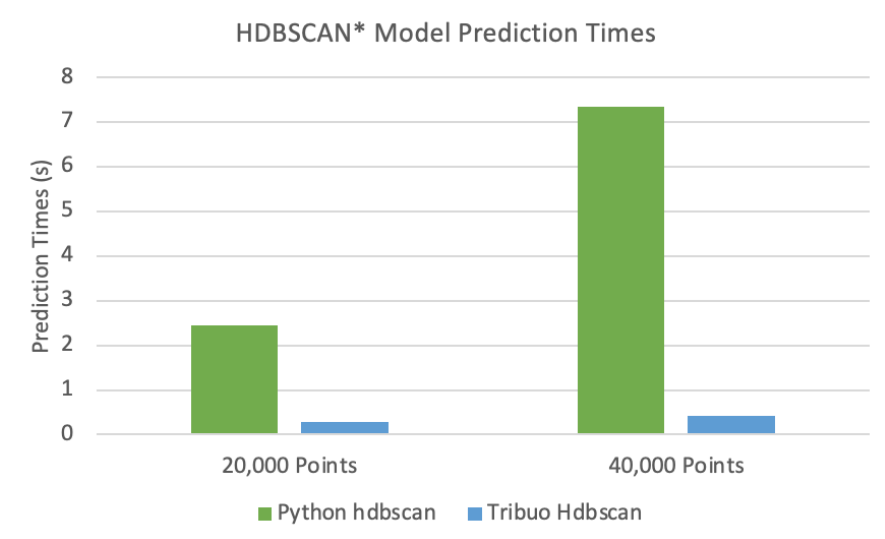
Figure 7. A clustered column chart comparing the model prediction times for the two